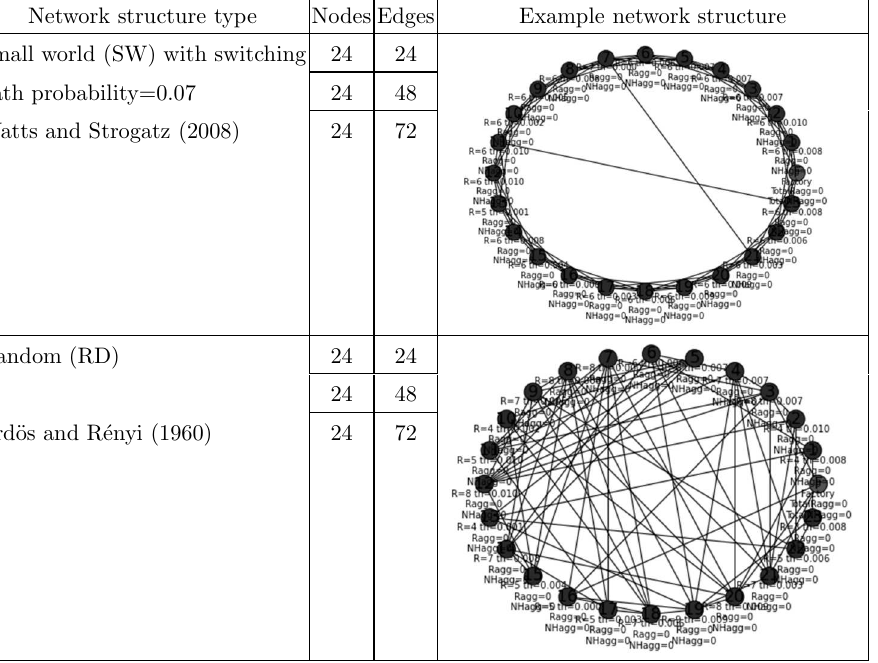
Table 1 Two network types with 3 different connectivity levels will be analyzed in simulation